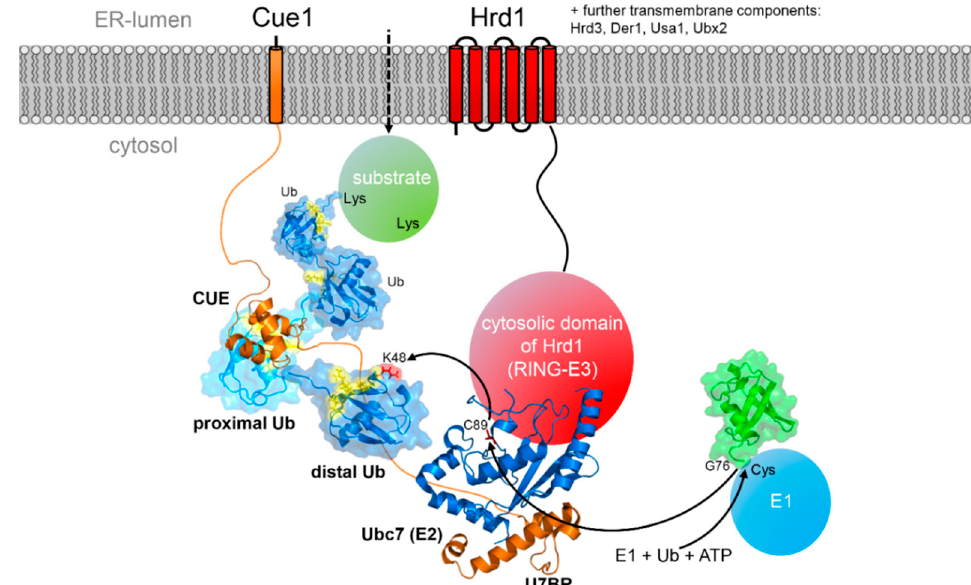
Figure 4. Schematic representation of the effect of the CUE domain of Cue1 on the Hrd1 dependent ubiquitination of a retrotranslocated substrate. The CUE domain preferentially binds to the proximal ubiquitin in the growing ubiquitin chain, thereby positioning Ubc7 that is also tethered to Cue1 via the U7BR domain relative to the substrate protein. Except for Hrd1 and Cue1 all other components of the Hrd1 complex are omitted for clarity.